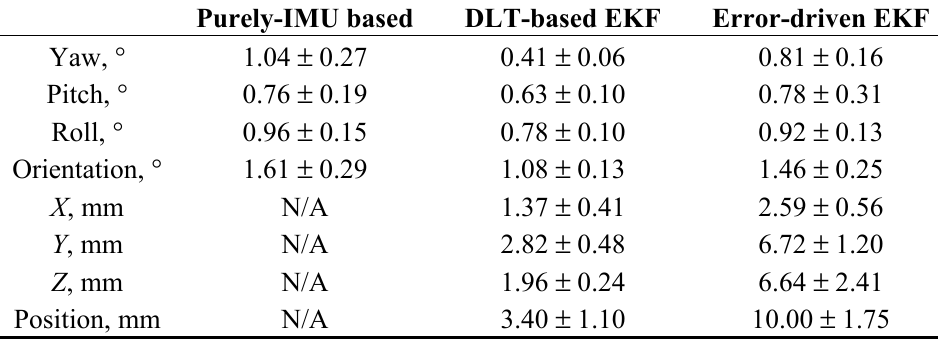
Table 3. Summary statistics of the performance metrics in the scenario (b).